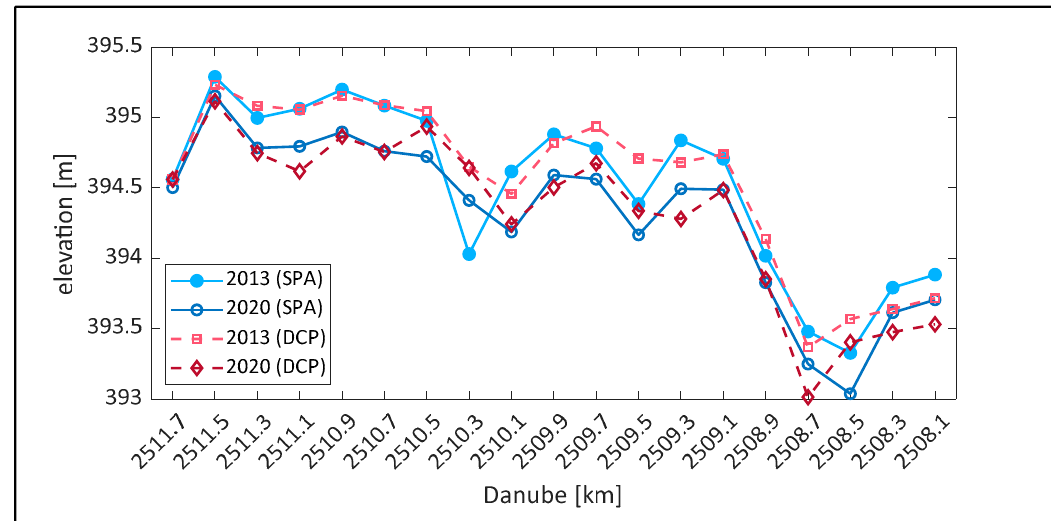
Figure 4. Development of the mean riverbed elevation for SPA data and DCP data from 2013 to 2020.